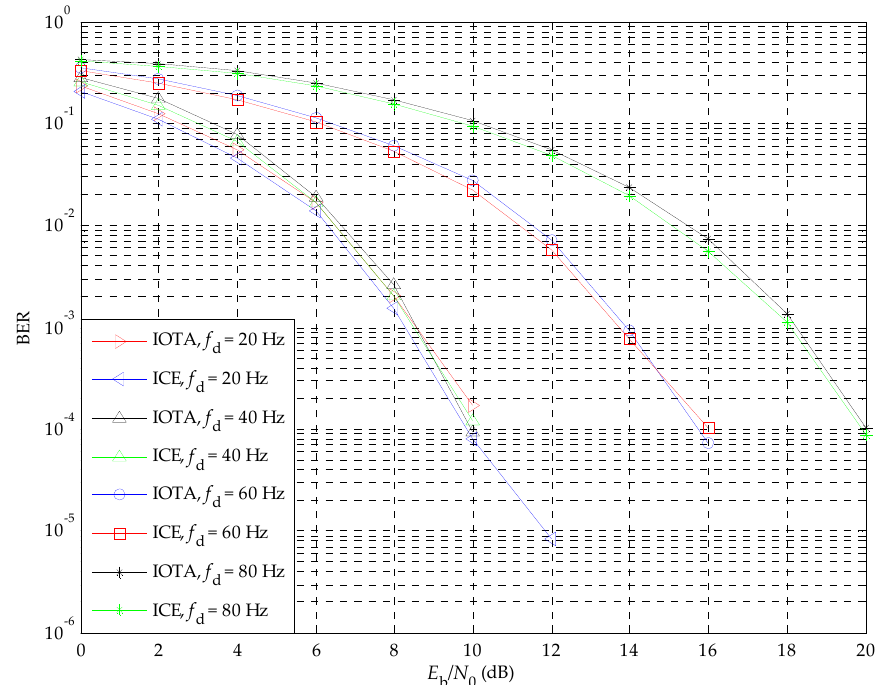
Figure 4. Bit error rate (BER) performance of the OFDM/OQPSK system over Rayleigh fading channels with Doppler spread of 20, 40, 60, and 80 Hz. ICE: ideal channel estimation.